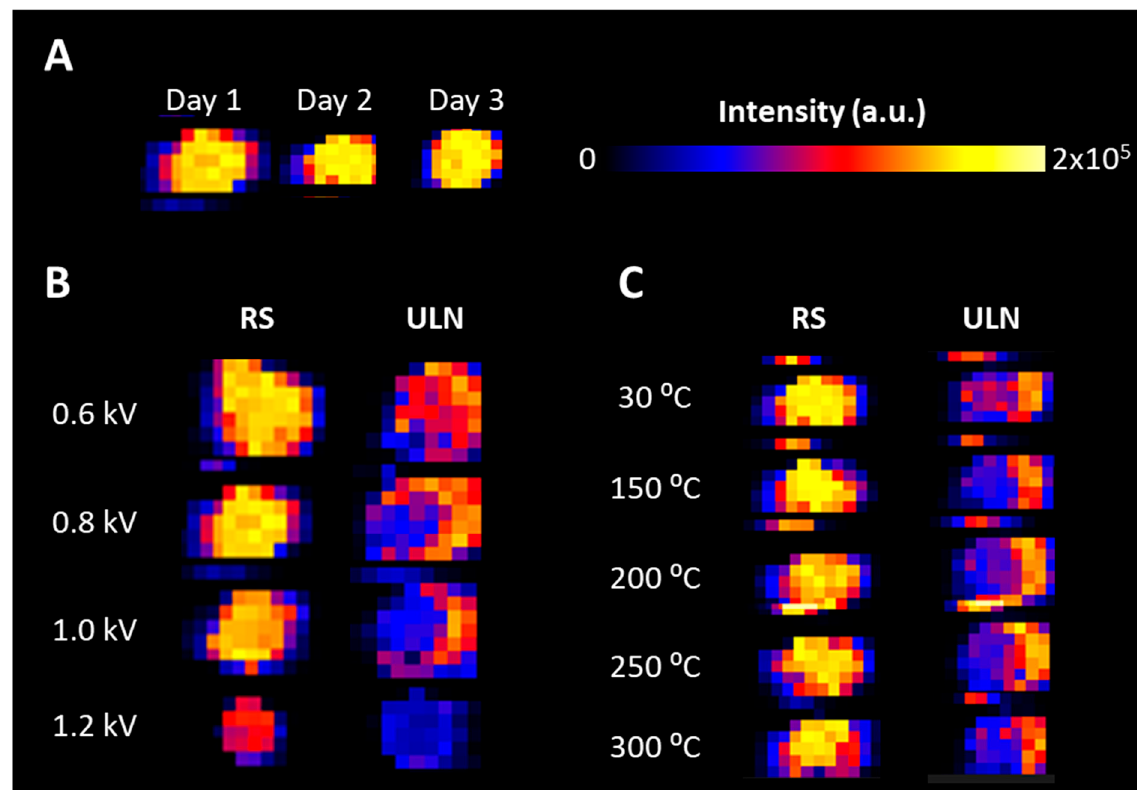
Figure 2. Optimization of the initial settings for DESI-MS analyses. Rhodamine C from a red staining marker (RS, m/z 443) and ulixertinib (ULN, m/z 433) were deposited on Aquarray superhydrophilic glass slides. ( A ) Signal stability was compared between images of RS acquired on three different days. ( B ) Different voltages were compared for RS and ULN analysis, both displaying the highest signal for a capillary voltage of 0.8 kV. ( C ) Different temperatures were tested for RS and ULN analysis, both displaying equal signals with any temperature.